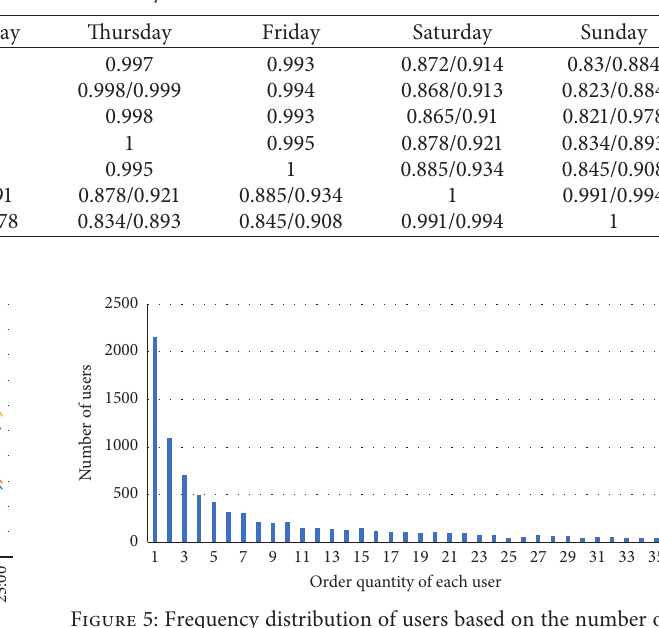
Table 2: Similarity coefficient of days in a week.